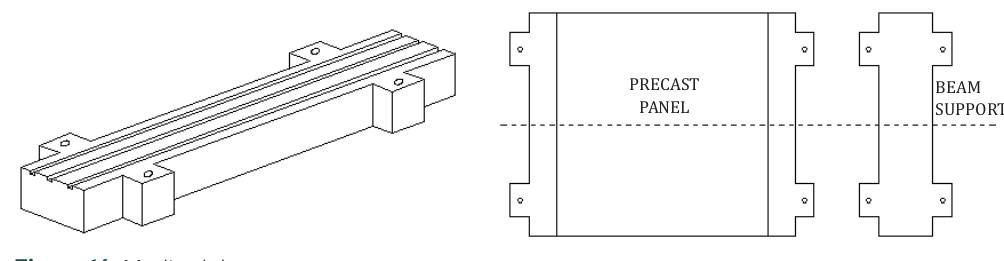
Figure 16. Modie slab